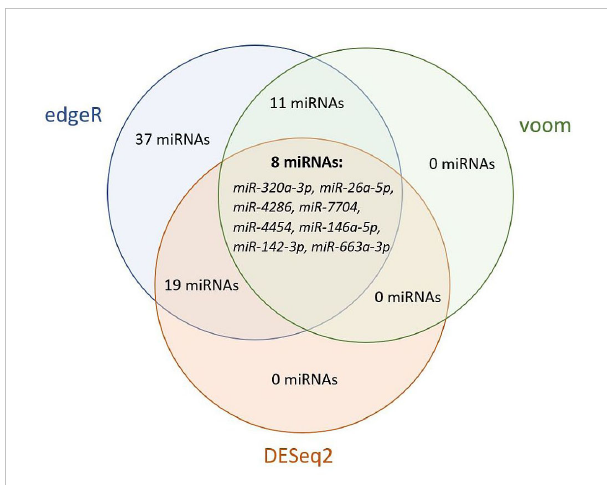
FIGURE 5 Venn diagram of statistically signi fi cant differentially expressed miRNAs by edgeR, voom, and DESeq2 algorithms. Evaluation using the DEApp web interface. The edgeR algorithm identi fi ed 75 miRNAs, the voom algorithm identi fi ed 19 miRNAs and the last algorithm DESeq2 identi fi ed 27 miRNAs that were statistically signi fi cantly differentially expressed. The intersection of all three algorithms identi fi ed 8 differentially expressed miRNAs.